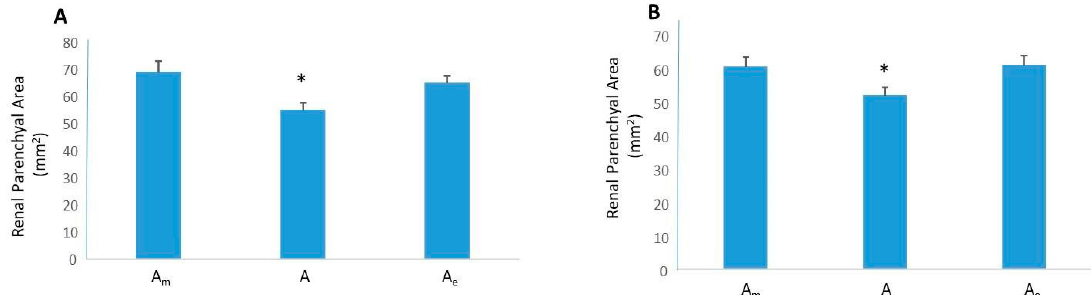
Figure 6. Renal parenchymal area in healthy and diseased mice (aristolochic acid + NaCl). Left and right kidneys were sourced from healthy adult male CD-1 mice or adult male CD-1 mice with aristolochic acid + NaCl nephropathy. ( A ) In coronal left kidney slices, Am is greater than A (*, p < 0.01) but not di ff erent from Ae . ( B ) In coronal right kidney slices, Am is greater than A (*, p < 0.01) but not different from Ae .